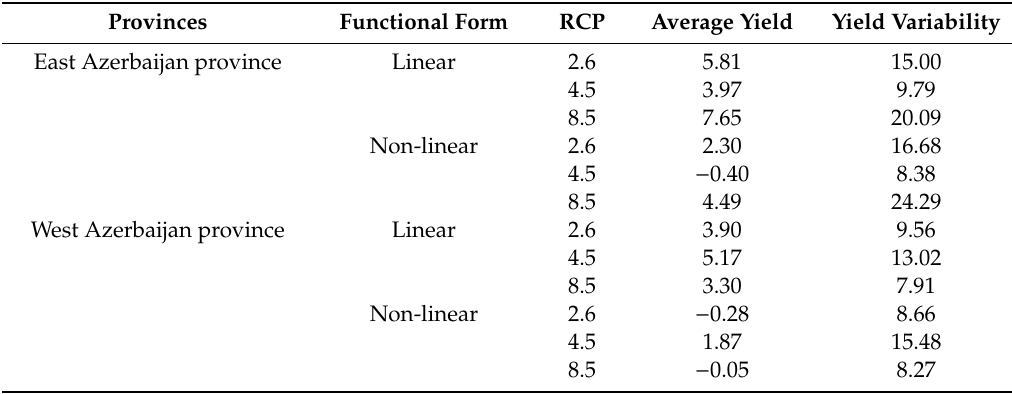
Table 9. Percentage changes in average yield and yield variability for East Azerbaijan and West Azerbaijan provinces under RCP 2.6, RCP 4.5, and RCP 8.5 for the period of 2041–2070, as compared to the base